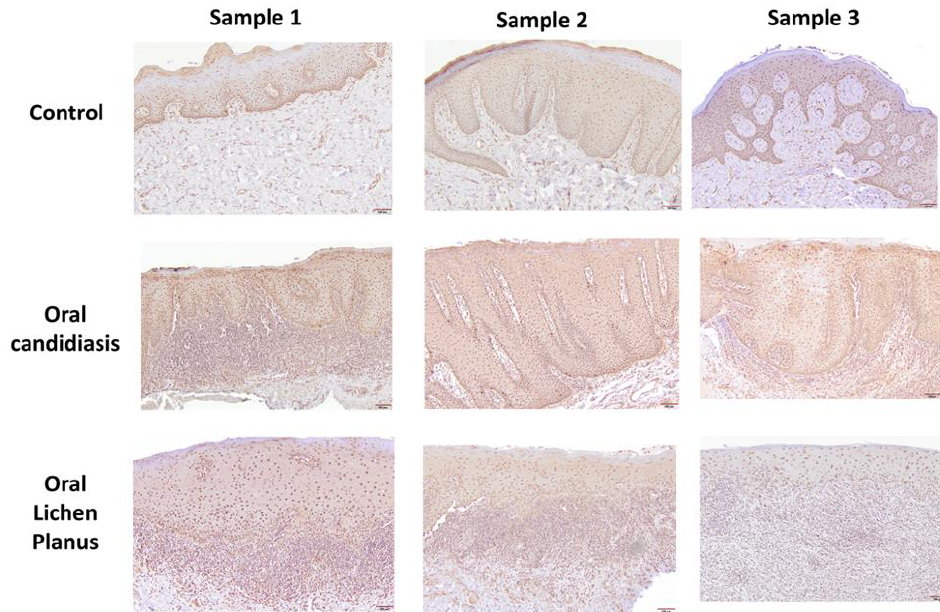
Figure 3. Panels show immunohistochemical staining for GILZ in three tissue specimens from each group of control, oral candidiasis, and oral lichen planus. For each condition, GILZ immunostaining was confined to nuclei. Scale bar: 100 μm.